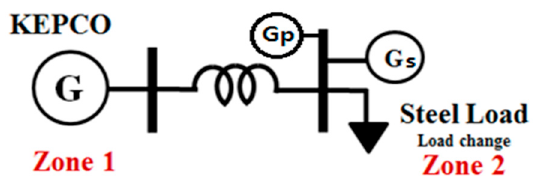
Figure 29. Power system model with a PR generator, labeled as G p .